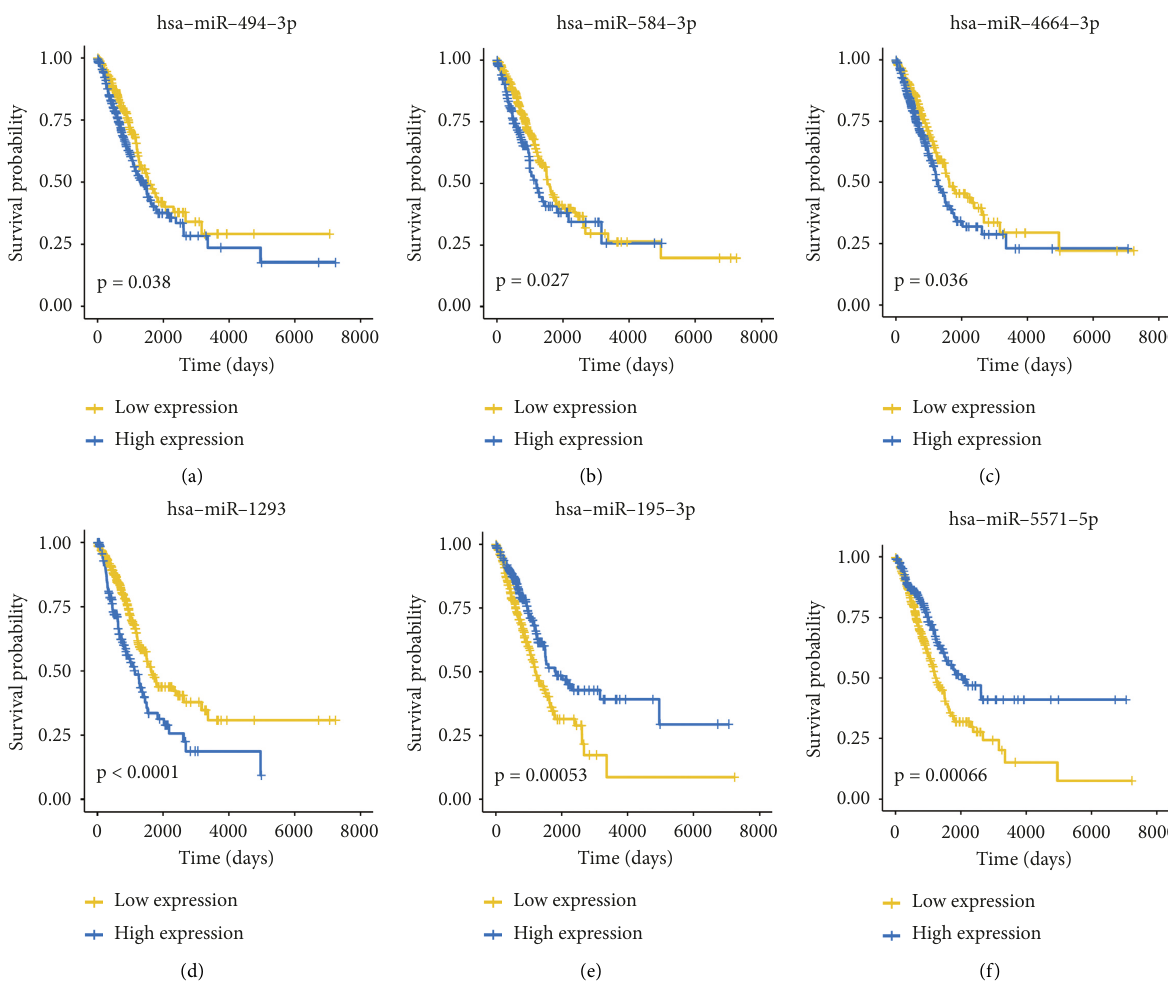
Figure 4: (a–f): KM survival curve of six microRNAs on OS in TCGA sample. p value was calculated by log-rank. The six genes can be used as independent prognostic variables for OS. Specifically, miR-1293, miR-195-3p, and miR-5571-5p were significantly related to OS. The greater the expression of miR-195-3p and miR-5571-5p, the better is the LUAD OS.(a) hsa-miR-494-3p; (b) hsa-miR-584-3p; (c) hsa-miR- 4664-3p; (d) hsa-miR-1293; (e) hsa-miR-195-3p; (f) hsa-miR-5571-5p.